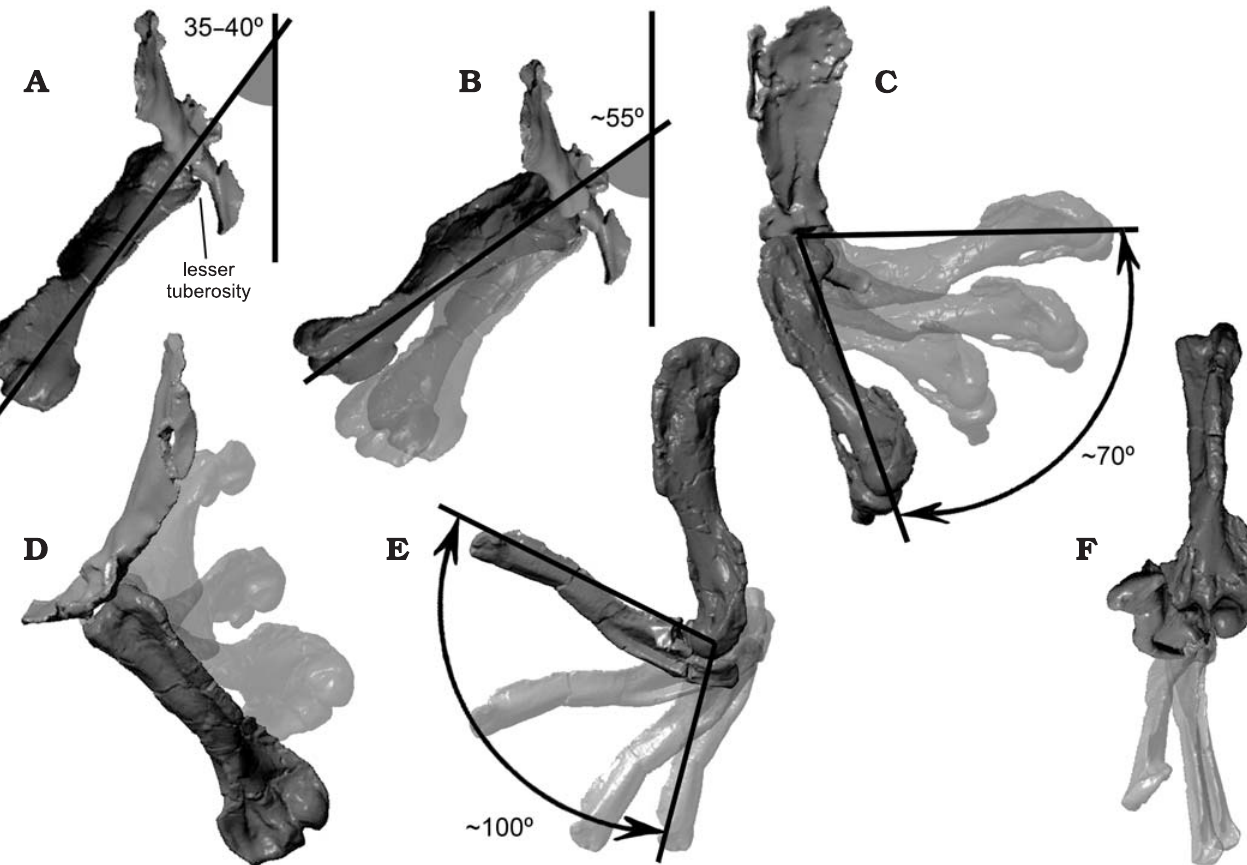
Fig. 6. Movements in the left shoulder and elbow of Trucidocynodon riograndensis . Maximal ( A ) and minimal ( B ) humeral adduction, in dorsal view; humeral protraction in lateral view ( C ), humeral rotation in anterior view ( D ); elbow flexion in lateral view ( E ), medial translation of ulna during elbow flexion in anterior view ( F ). Darker shaded steps, in E and F the radius was not